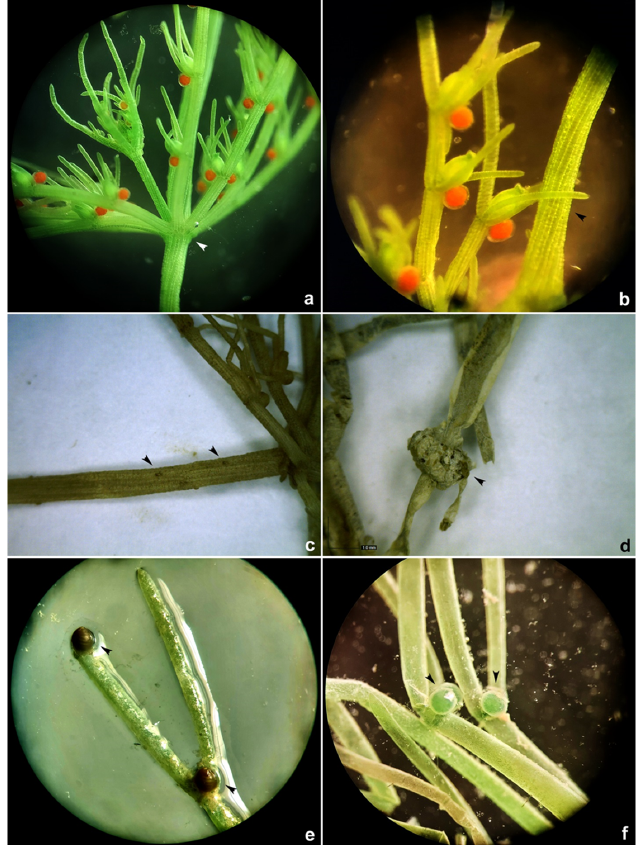
Figure A5. Chara vulgaris ( a – c ), Nitellopsis obtusa ( d – f ): ( a )—base of branchlet whorl with typical short obtuse stipulodes (arrowhead), Kapchagay Reservoir, ( b )—branchlet nodes with conjoined gametangia and aulacanthous stem cortex (arrowhead), Kapchagay Reservoir, ( c )—aulacanthous stem cortex with adpressed short solitary spine cells (arrowheads), Sharyn River, ( d )—nodal bulbil (arrowhead), Ostemir pond, ( e )—fertile nodes with oogonia (arrowheads), Canal Arystan, ( f )—fertile nodes with antheridia (arrowheads), Arystan channel. Scale: 1 mm, both for ( c , d ). Photos ( a , b , e , f )—by G. Jumakhanova, ( c , d )—by S.S.